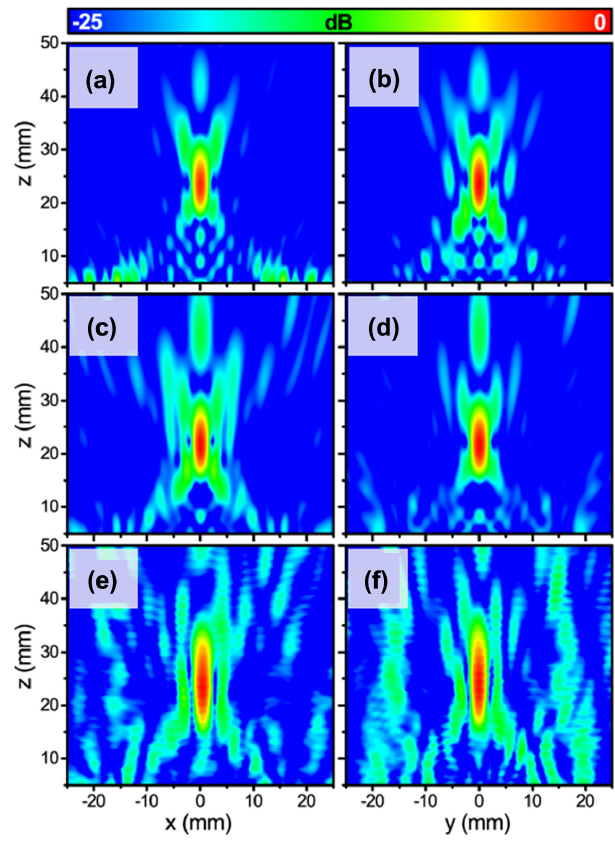
Figure 3. Normalized spatial power distribution on the xz -plane (left column) and yz -plane (right column) for: (a, b) analytical results at 99 GHz; (c, d) simulation results at 99 GHz; (e, f) experimental results at 99